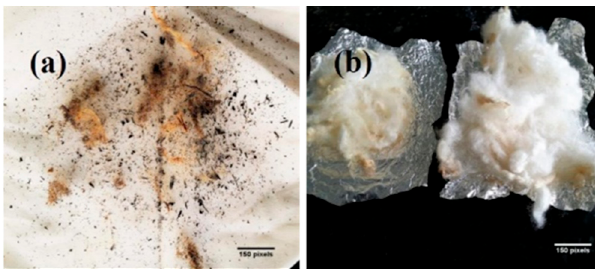
Figure 10. Carbonized ( a ) vegetable matter ( b ) wool.